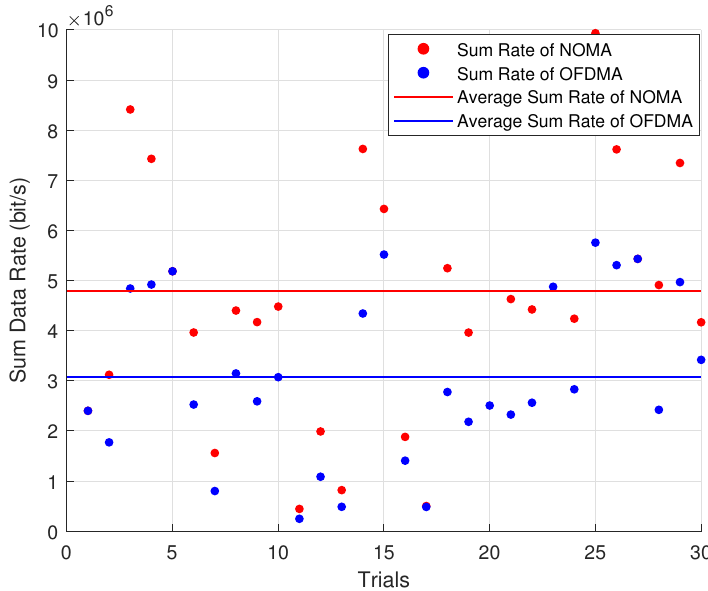
Figure 12. Data rate comparison of NOMA vs. OFDMA in rural areas.